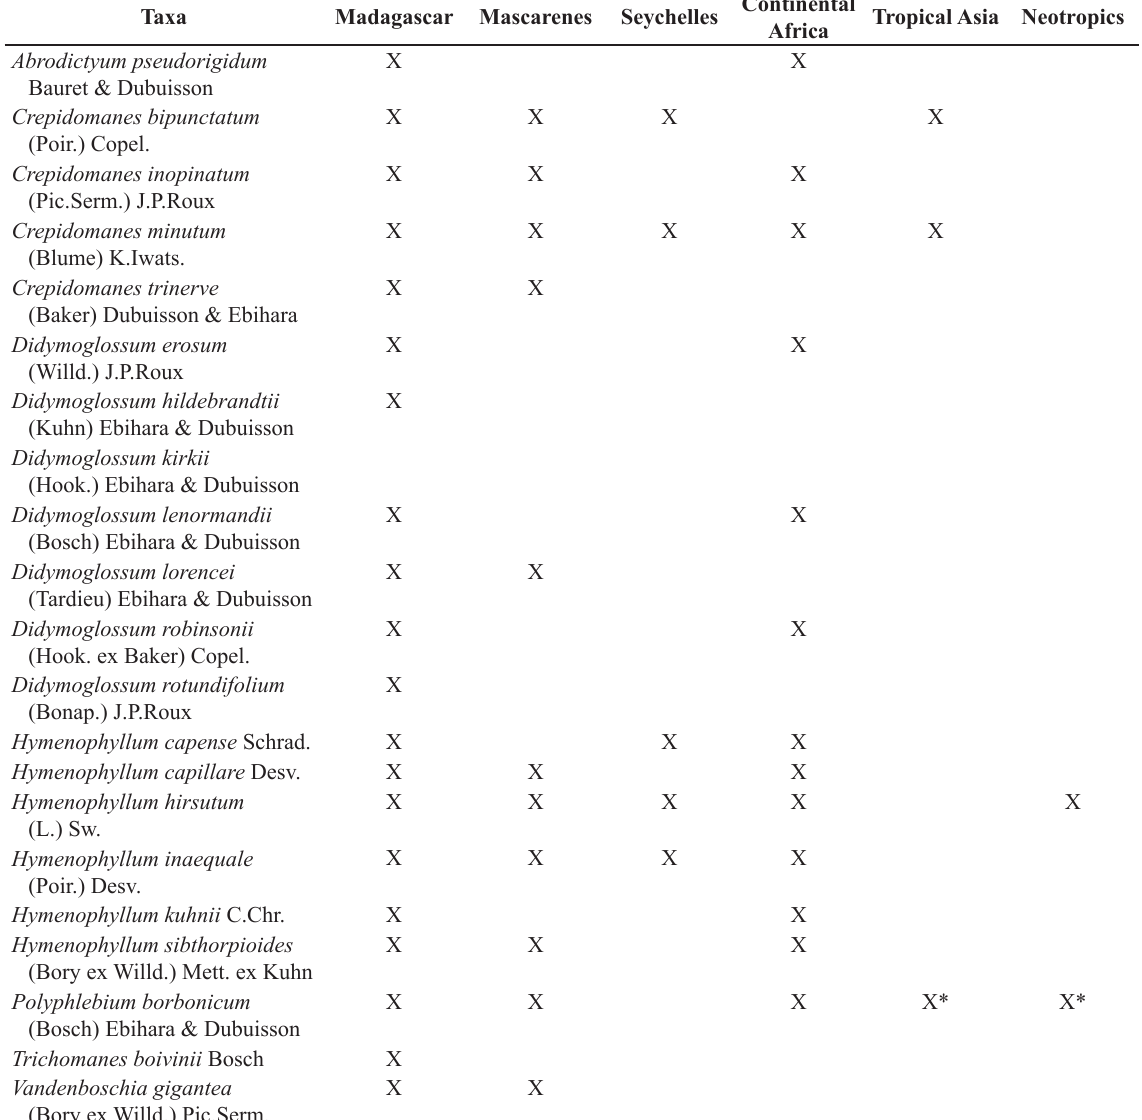
Table 3. List of Hymenophyllaceae species recorded for the Comoros archipelago and their occurrence in other areas. * According to Ebihara et al. (2009), P. borbonicum would be distributed from the Neotropics to tropical Africa (in addition to the Pacific islands and Australia). X = present or reported